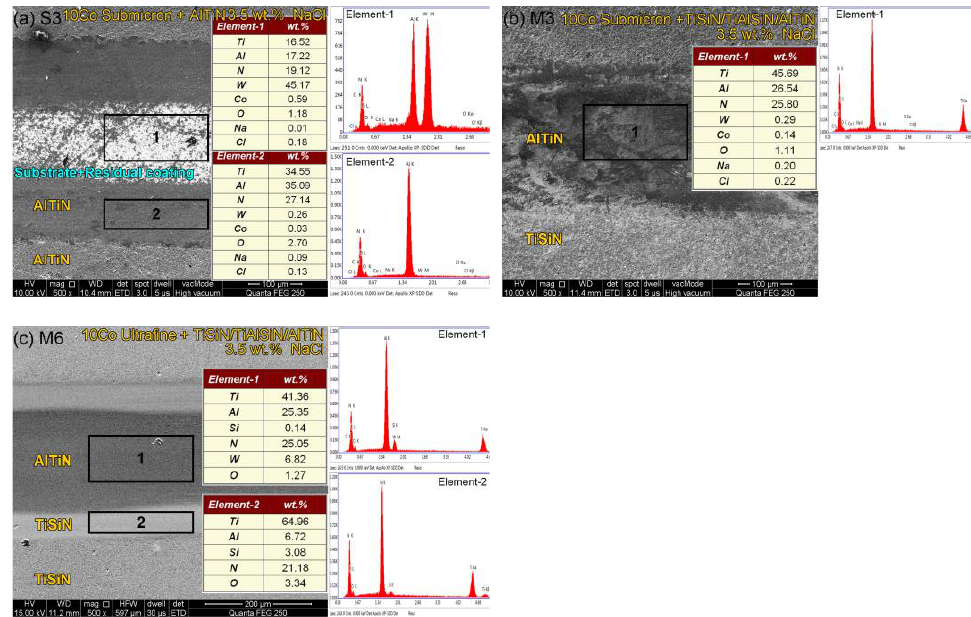
Figure 8. SEM images and EDS analysis results of the wear tracks of typical coated cemented car- bides in the air and 3.5% NaCl aqueous solution: ( a ) S3, ( b ) M3, ( c )